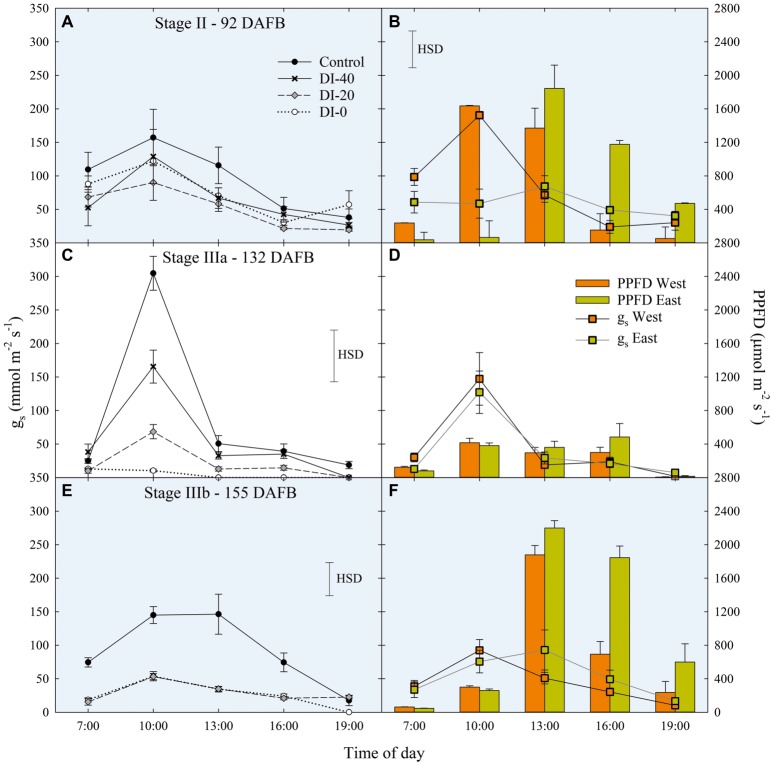
Daily curves of leaf stomatal conductance (gs) at stages II (A), IIIa (C), and IIIb (E) of ‘September Bright’ nectarine fruit growth, and in West- and East-oriented trees [Stage II (B), IIIa (D), IIIb (F)]. Trees irrigated to 100% (control), 40% (DI-40), 20% (DI-20), and 0% (DI-0) of crop evapotranspiration. Bars in panels (B), (D), and (F) show means of photosynthetic photon flux density (PPFD) for West- and East-oriented trees. Bars represent standard errors of means (irrigation treatment n = 6; canopy orientation n = 12). Significant differences determined with analysis of variance and Tukey’s honestly significant difference (HSD, p < 0.05). The HSD bars in panels (B,D,F) represent only differences in gs, and not in PPFD (only used as a reference).